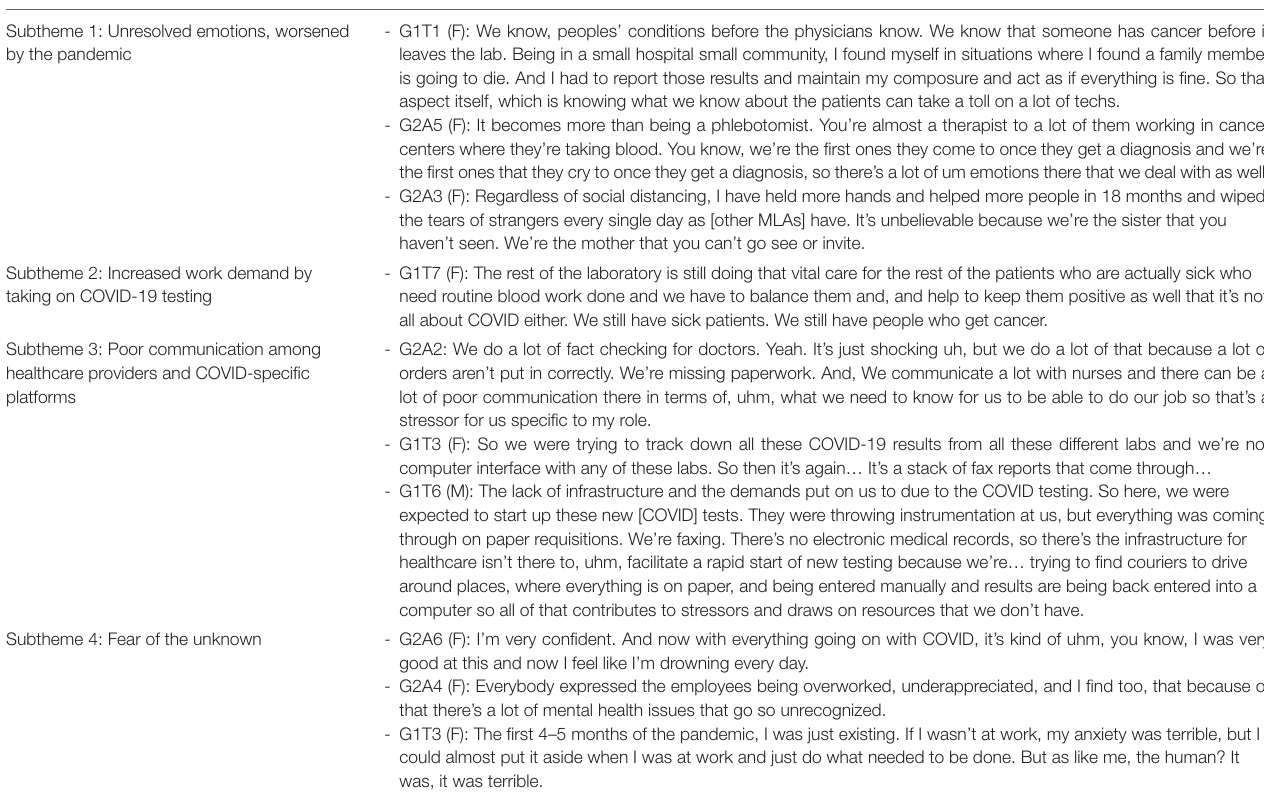
TABLE 5 | Theme 3: Poor work environment, exacerbated by the pandemic. Subtheme 1: Unresolved emotions, worsened by the